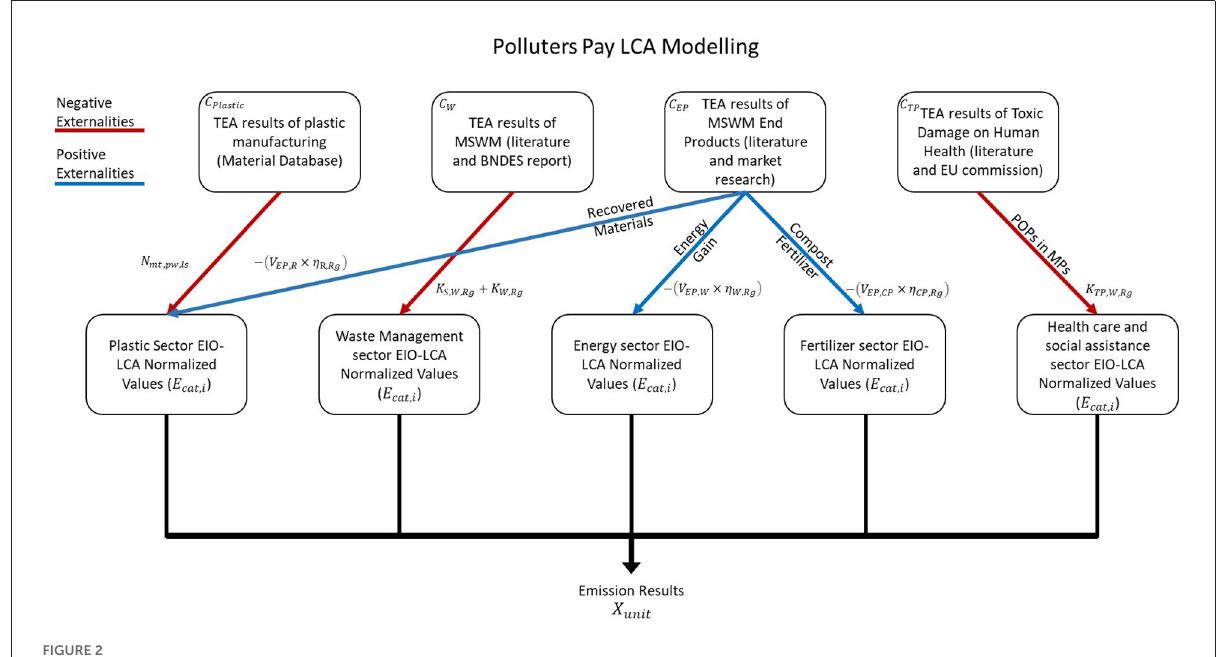
FIGURE2 Diagram of PP-LCA